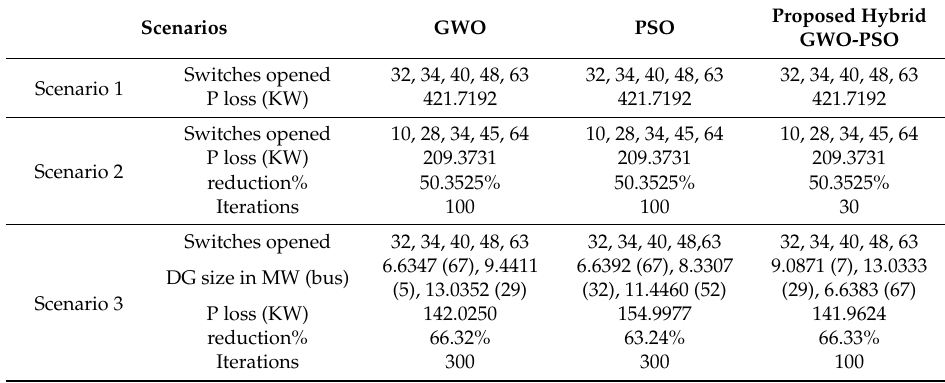
Table 8. Comparison of simulation results for P-type DG units of the 78-bus